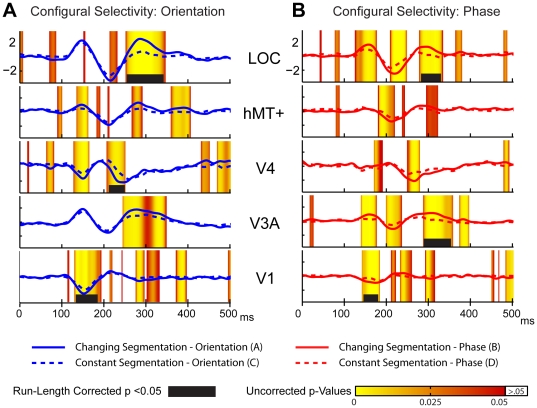
Source-space configural selectivity contrasts.Responses waveforms in 5 visual cortical areas showing configural selectivity to the appearance (2nd half cycle) of the (A) orientation and (B) phase defined forms. Global field power for the changing (solid) and constant (dashed) configurations of the orientation-defined (blue) and phase-defined (red) stimuli.